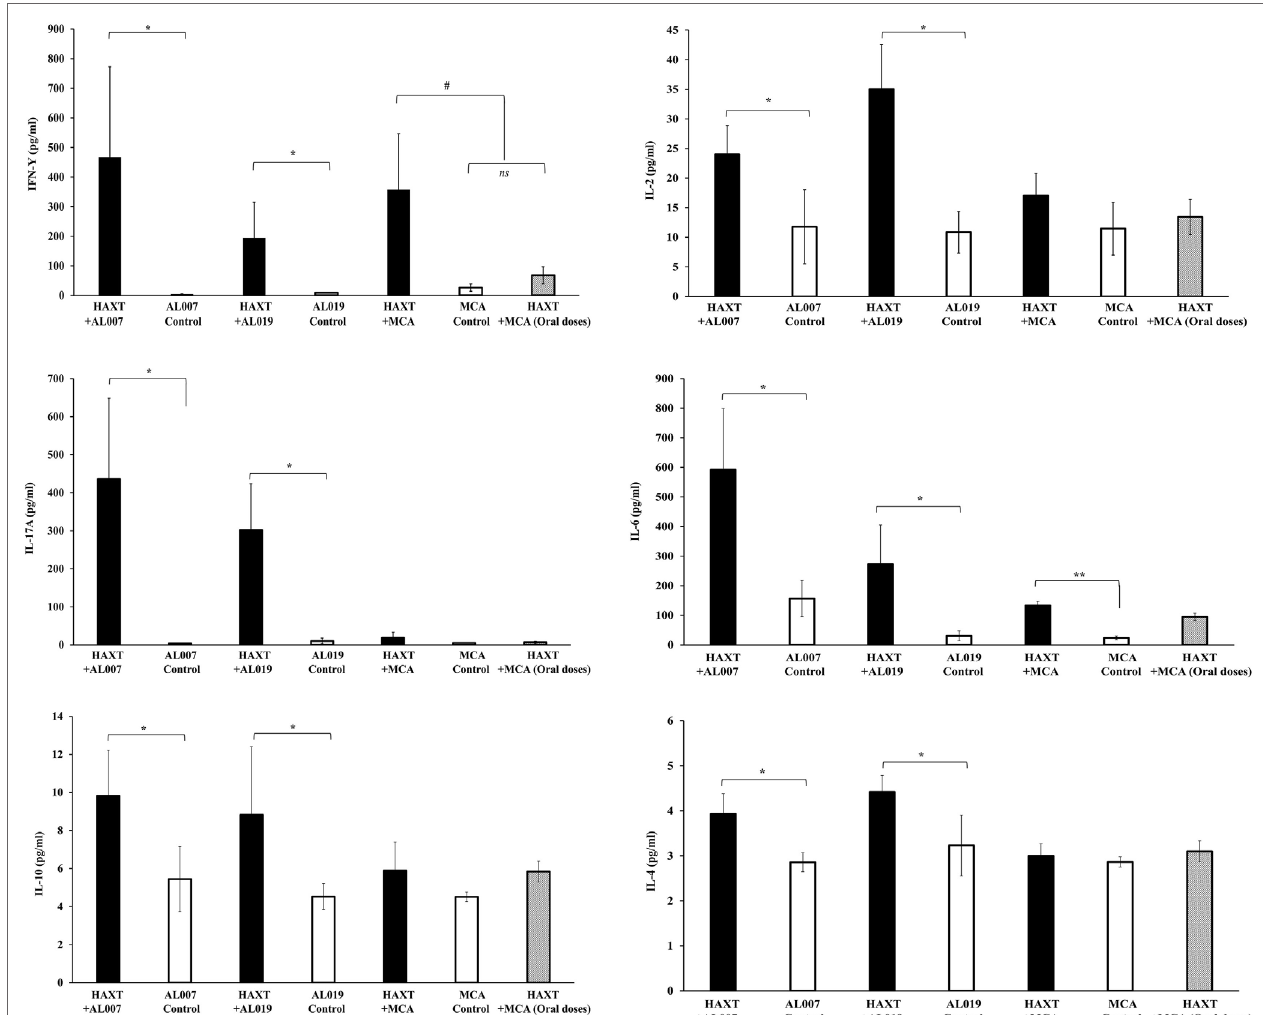
FigUre 5 | Level of cytokines (IFN- γ , IL-2, IL-6, IL-17A, IL-4, and IL-10) in culture supernatant of spleen cells were determined by cytokine bead array. After 72 h incubation, culture supernatant was collected and stored in − 80°C until use. 50 µl of supernatant was used in the assay as per the manufacturer recommendation. Results showed that r Bm HAXT + AL007 and r Bm HAXT + AL019 were better in the expression of both Th1/Th2 cytokines compared to rBm HAXT + mannosylated chitosan group. This showed that AL007 and AL019 can produce balanced Th1/Th2 cytokines response. * p < 0.05, # p < 0.01, ** p < 0.001 compared to respective group, ns = not significant as analyzed by Kruskal-Wallis test followed by Bonferroni correction for multiple